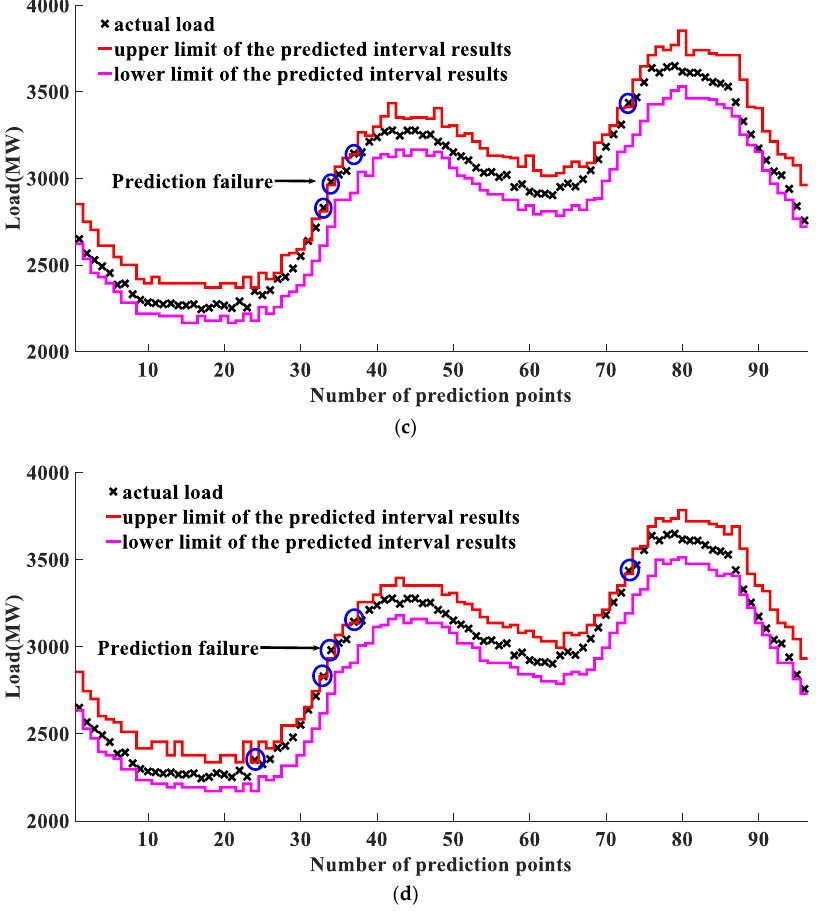
Figure 4. Prediction results of applying four methods in region 1: ( a ) Prediction results based on the optimal parameter K and t ; ( b ) prediction results of artificial neural network (ANN); ( c ) prediction results based on extreme learning machine (ELM); ( d ) prediction results of Gaussian process regression (GPR) algorithm.